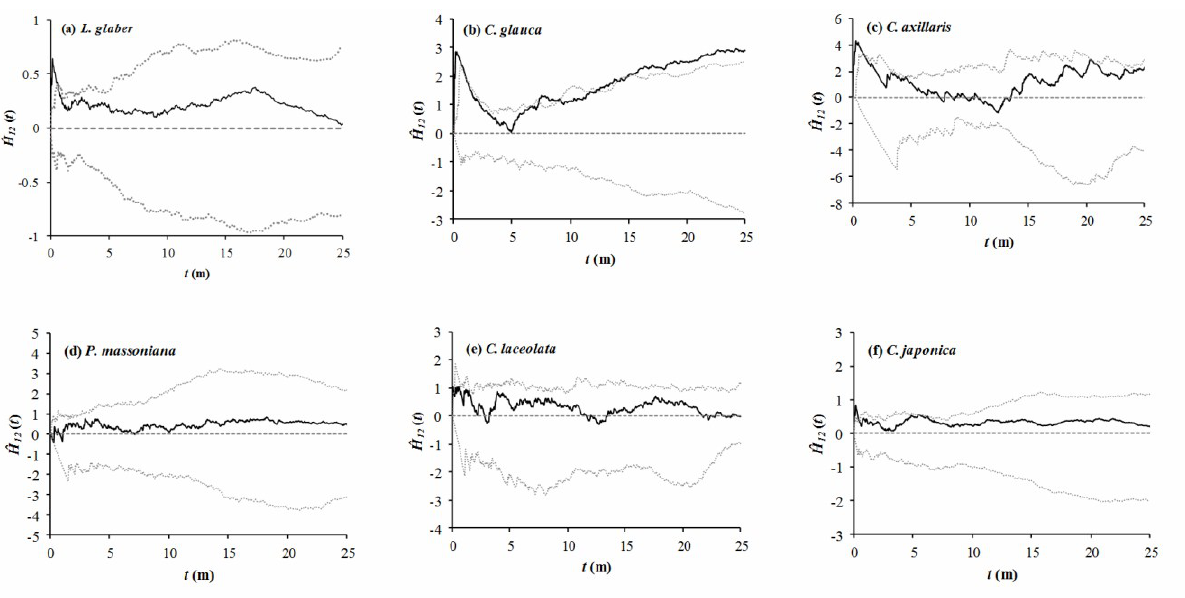
Figure 4. Spatial associations between the six dominant species in a subtropical broadleaved evergreen forest plot on Dashanchong Forest Farm, China. Solid lines represent Ĥ values and dashed lines are the upper and lower limits of the 95% confidence envelope of Ĥ ( t ) generated by 999 computation of Monte Carlo (where t is the distance).